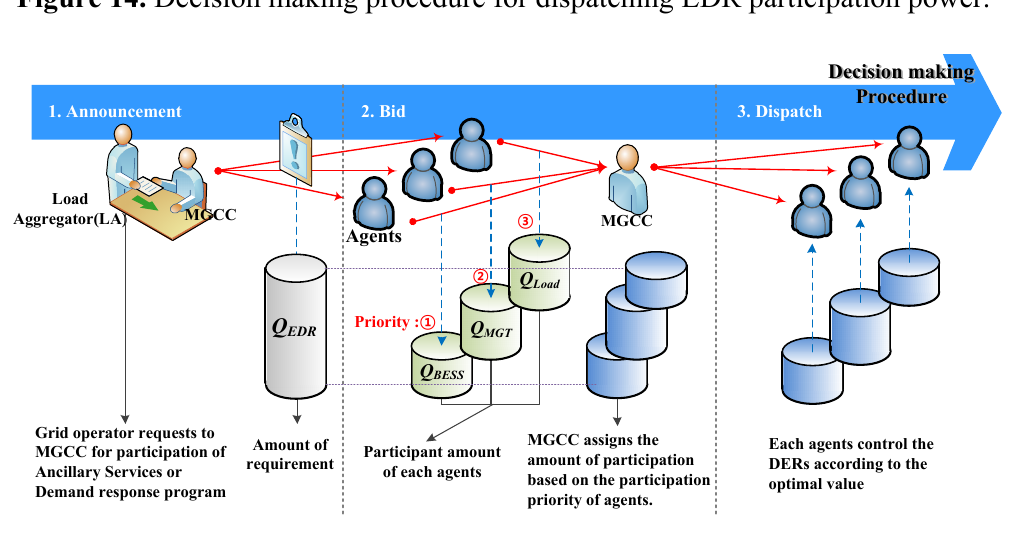
Figure 14. Decision making procedure for dispatching EDR participation power.